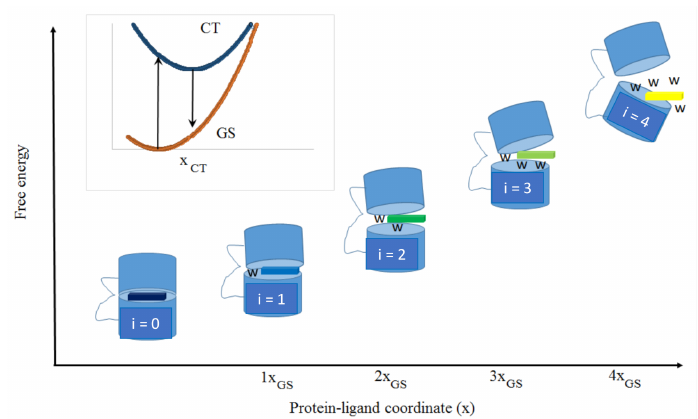
Figure 1. Idealized thermodynamic model for ligand–protein interactions. Free energy of protein– ligand microstates (i = 0 to 4) as a function of generalized protein–ligand coordinate (x). In this model, the protein–ligand microstates are equally spaced ( x GS ). The blue bi-cylindrical shapes depict the protein, ligand is represented by the colored rectangles, while bound water molecules are represented by the letter w. The change in color of the ligand along coordinate x represents the change in spectroscopic parameters of the ligand (i.e., red-shift in absorption and emission). Inset: Marcus free energy surfaces for the ligand ground state (GS) and ligand excited-state (CT) with xCT (the change in geometry of the ligand in the CT state)